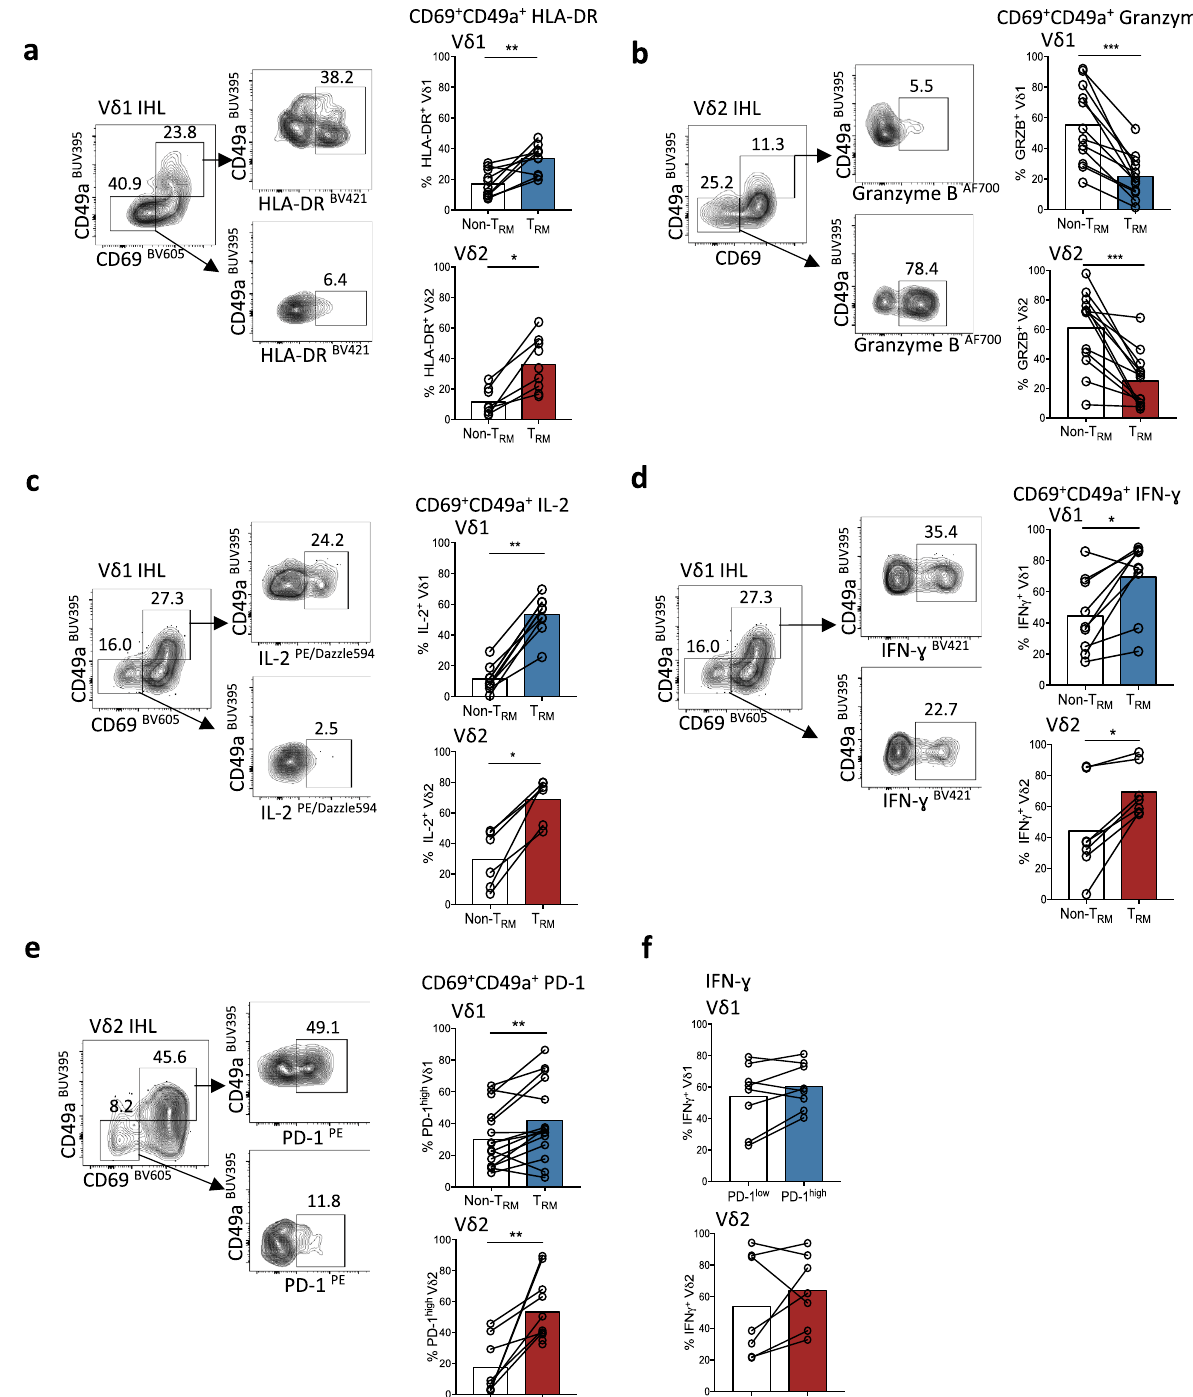
Fig. 3 Distinct functional pro fi le of hepatic γδ T RM . a – e Representative fl ow cytometry plots and summary data of ex vivo functional pro fi le of intrahepatic CD69 + CD49a + V δ 1 and V γ 9V δ 2 T RM compared to non-T RM (CD69 − CD49a − ) counterparts. a HLA-DR expression ( n = 13; V δ 1 p = 0.008; V γ 9V δ 2 p = 0.03). b unstimulated Granzyme B expression ( n = 17; V δ 1 p = 0.0005; V γ 9V δ 2 p = 0.0002). c IL-2 expression following 4 h PMA and Ionomycin stimulation ( n = 10; V δ 1 p = 0.004; V γ 9V δ 2 p = 0.03). d IFN- γ expression after 4 h PMA and Ionomycin stimulation ( n = 10; V δ 1 p = 0.01; V γ 9V δ 2 p = 0.02). e unstimulated programmed death-1 (PD-1) expression ( n = 11; V δ 1 p = 0.007; V γ 9V δ 2 p = 0.008). f IFN- γ expression by PD-1 high and PD-1 low intrahepatic V δ 1 and V γ 9V δ 2 T-cells after 4 h PMA and Ionomycin stimulation ( n = 8; p value non-signi fi cant). Each symbol represents a study participant, with bars showing the mean ( a – f ); two-tailed p -values were determined using Wilcoxon matched-pairs signed rank test ( a – f ). * p < 0.05; ** p < 0.01; *** p < 0.001.